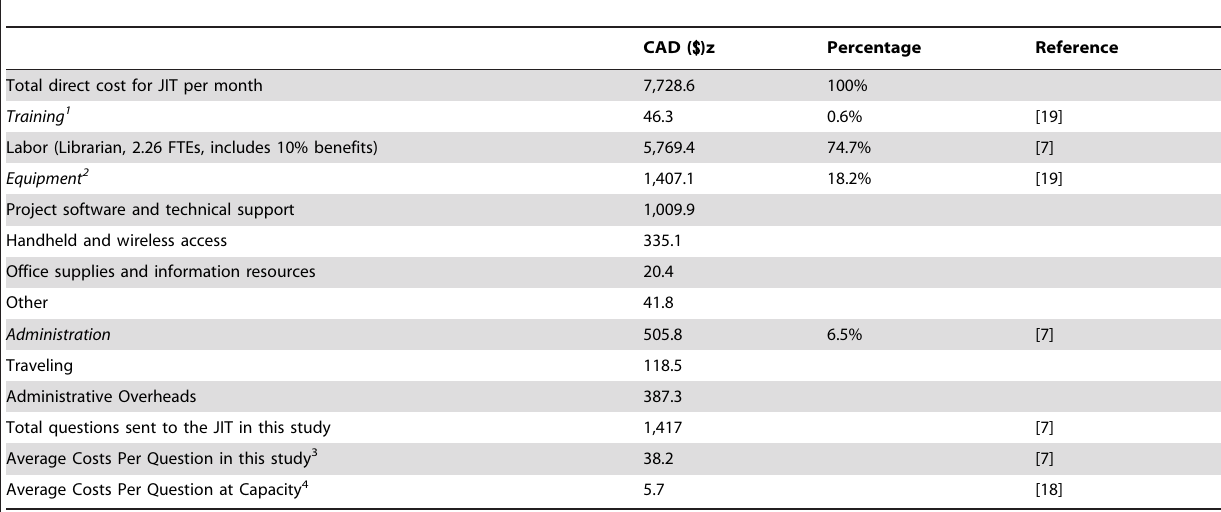
Table 1. Resources utilization for JIT Service (2006 Canadian